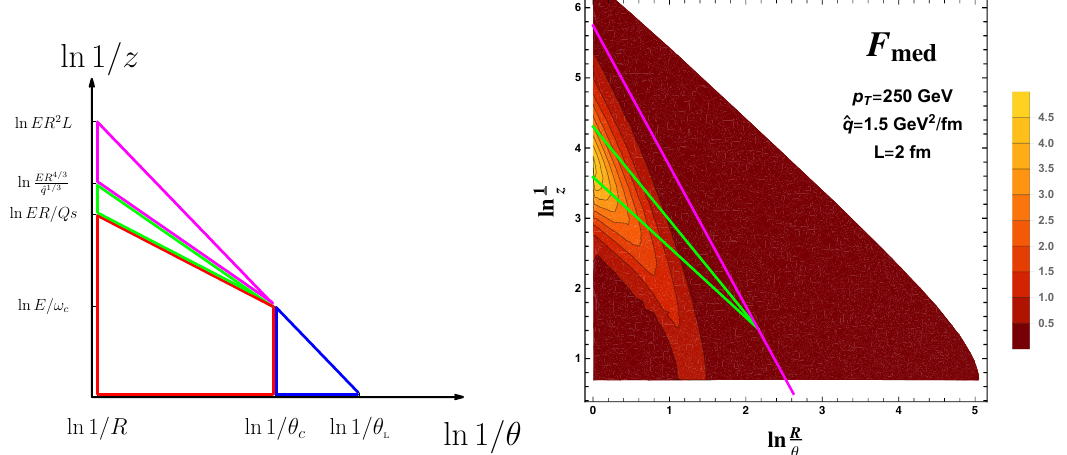
Figure 3. Lund diagram for one splitting ( left panel ) and numerical evaluation of the medium modification factor in the Lund plane ( right panel